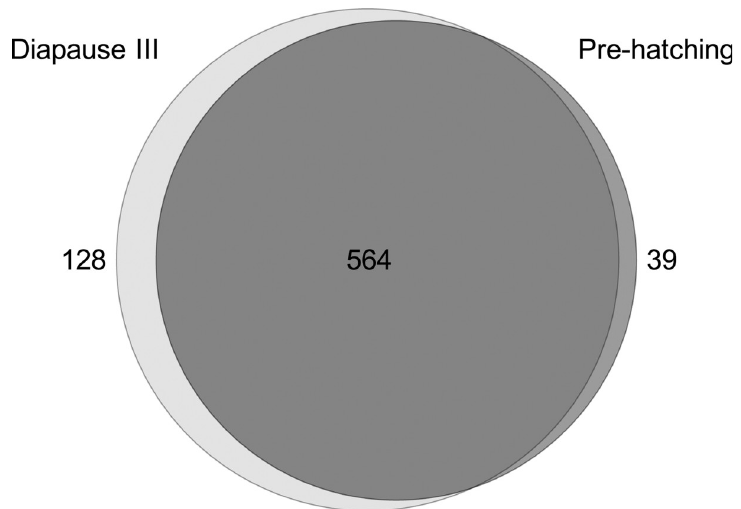
Fig 2. Venn diagram. Venn diagram showing proteins detected in prehatching (PRE) and diapause III (DIA). A protein was considered uniquely detected in PRE or DIA when it was identified in at least 2 replicates of one condition and was absent in the other. The number of proteins detected as uniquely present in DIA and PRE are shown light and dark gray, respectively. The overlapping section indicates the number of proteins common to both conditions.